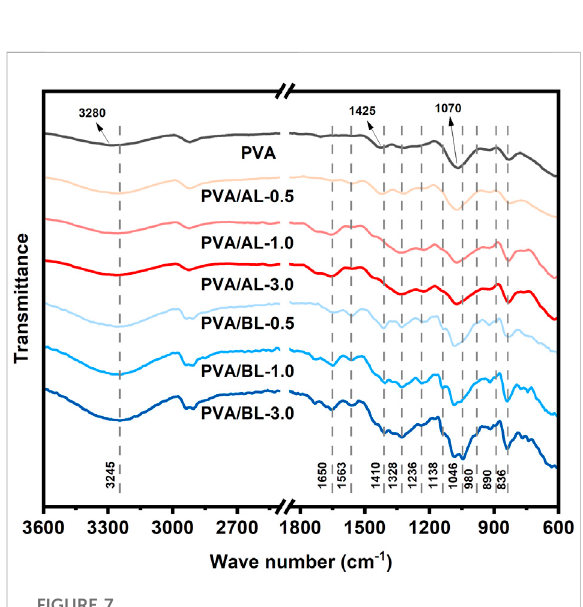
FIGURE 7 FT-IR spectra of PVA, PVA/AL, and PVA/BL composites.